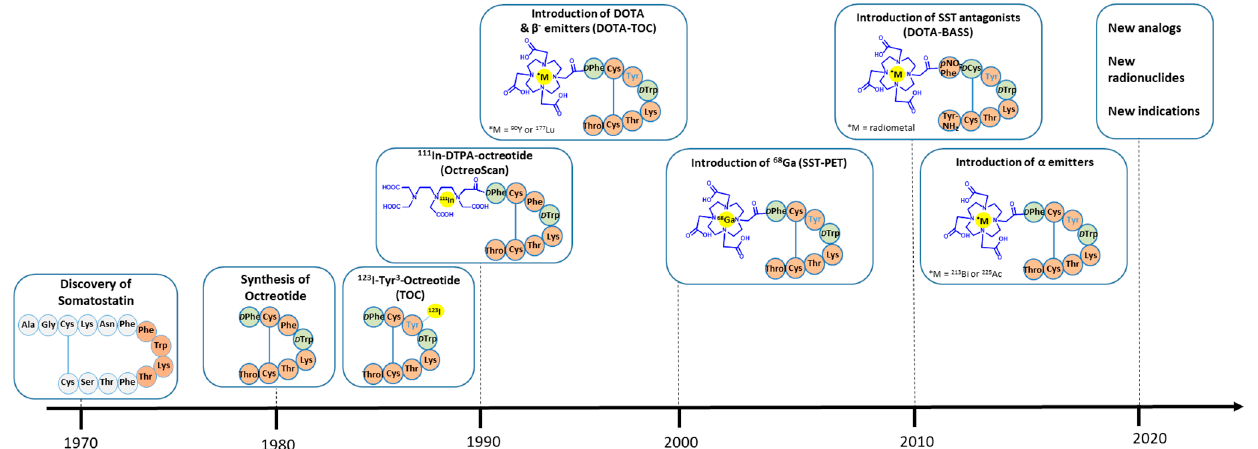
Figure 1. Evolution in the development of radiolabeled somatostatin analogs. Color code: orange for L-amino acids (also showing the essential amino acids (tetrapeptide) in the somatostatin sequence for receptor recognition), green for D-amino acids, blue for chelators, and yellow for radio- nuclides.